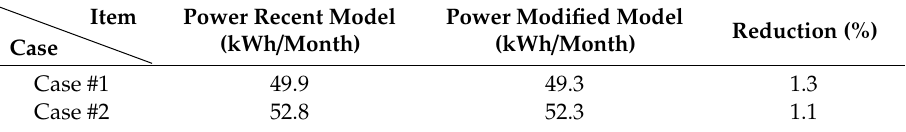
Table 4. Reduction in power for recent and modified